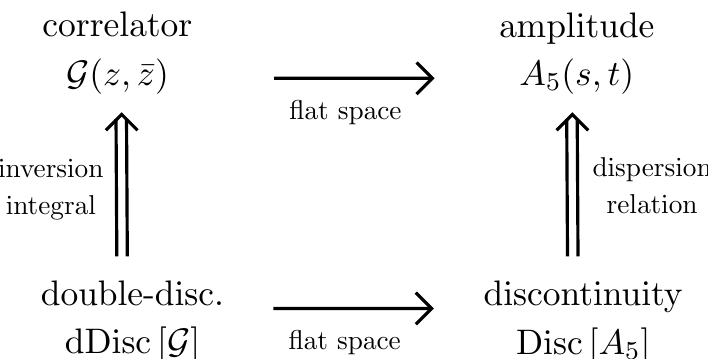
Figure 7 . A commutative diagram which explains the agreement between the one-loop CFT and supergravity calculations: the discontinuities, which determine the outcome of both calculations, match each